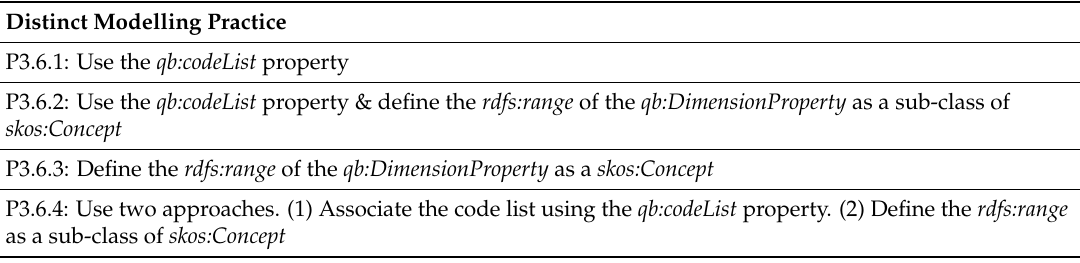
Table 38. Distinct modelling practices of data portals for associating the dimensions to code